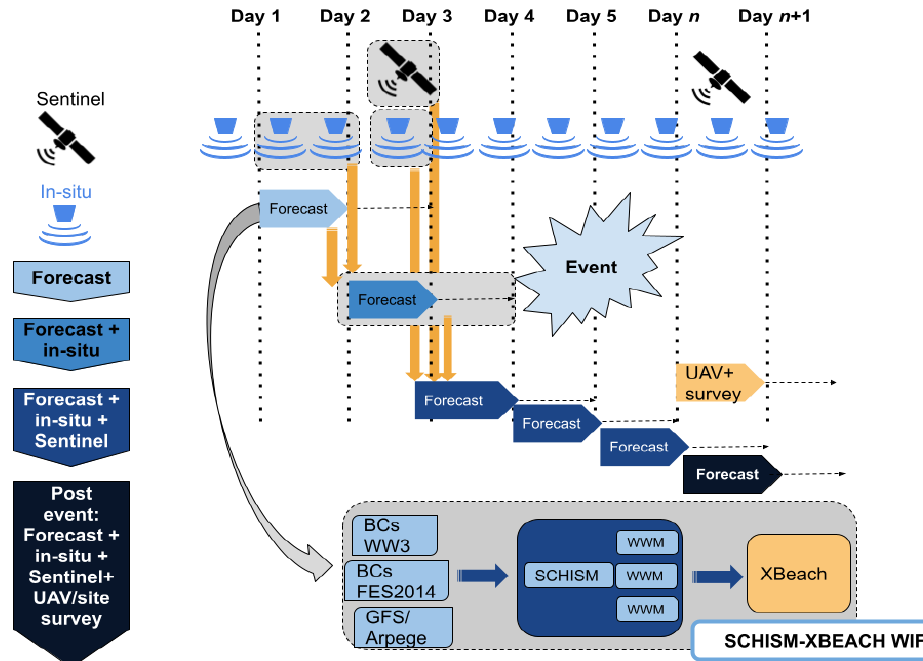
Figure 2. Monitoring framework workflow. In the inset, the forecasting workflow is detailed, where the following acronyms stand for: BCs: boundary conditions, FES2014—the Finite Element Solution Global Ocean Tidal Atlas (2014 results), WW3: WaveWatch 2 model, GFS—(weather) Solution Global Ocean Tidal Atlas (2014 results), WW3: WaveWatch 2 model,